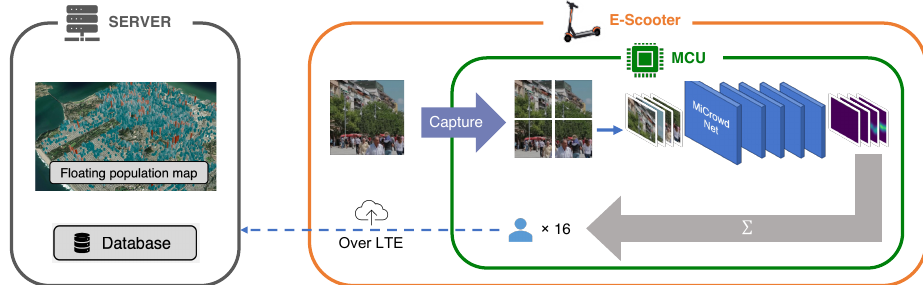
Figure 3. An overview of MiCrowd . E-scooters predict floating populations from their camera images using MiCrowdNet. The predicted population is sent to the server wirelessly and aggregated for